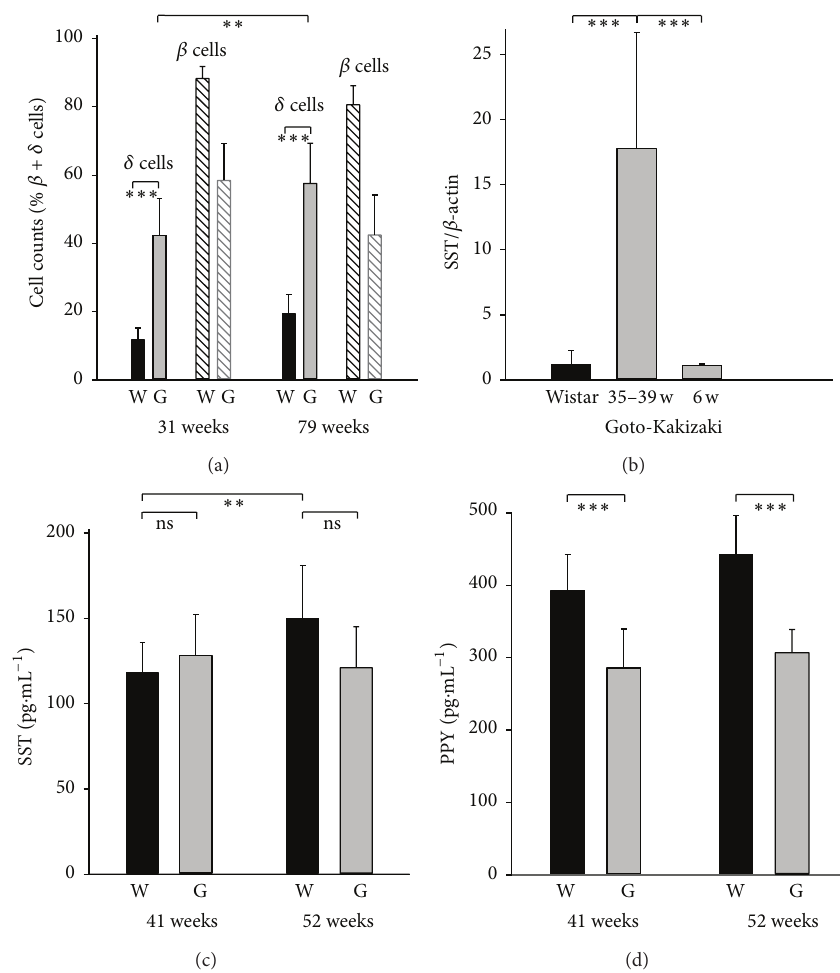
Figure 5: Delta cell versus beta cell counts and somatostatin pancreatic and serum levels plus PPY serum levels in Wistar and GK rats. (a) Cell counts from immunohistochemical PI sections of Wistar “W” ( 𝑛 = 6 samples) and GK rats “G” ( 𝑛 = 9 samples) as % fraction of beta plus delta cells for cells as specified at the age of 31 and 79 weeks ( ∗∗ 𝑝 < 0.01 ; ∗∗∗ 𝑝 < 0.001 ). (b) SST mRNA quantification as the relative SST/beta actin ratio in PI of Wistar (black bar) and GK rats (gray bars) indicates ∼ 14-fold increase of SST mRNA. Five estimates ( 𝑛 = 5 ) at weeks 6 and 35, 37, or 39 ( ∗∗∗ 𝑝 < 0.001 ). (c) SST and (d) PPY in serum collected from the tail vein of Wistar “W” (black bars) and Goto-Kakizaki “G” (gray bars) rats aged 41 and 52 weeks ( ∗∗∗ 𝑝 < 0.001 ( 𝑛 = 11 ); for Wistar SST otherwise 𝑛 = 6